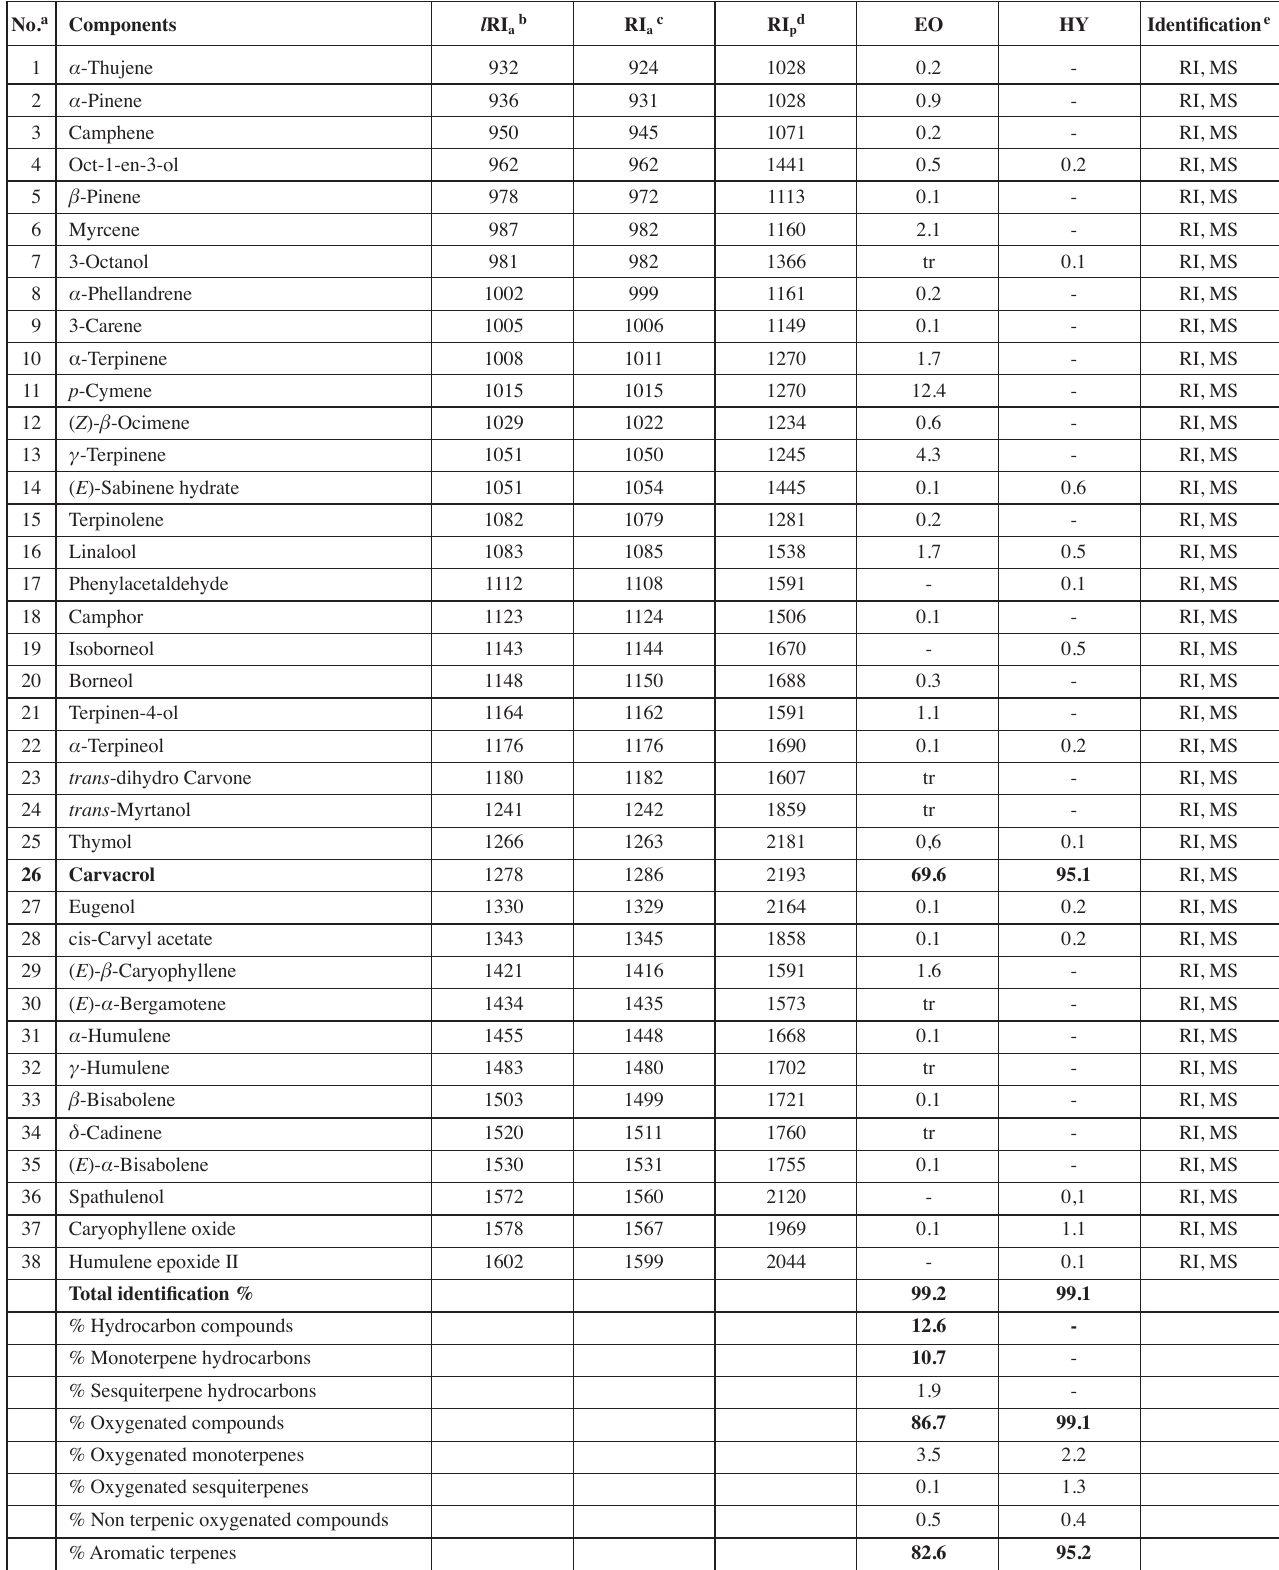
Tab. 1: Chemical compositions of T. capitatus essential oil (EO) and hydrosol extract (HY).